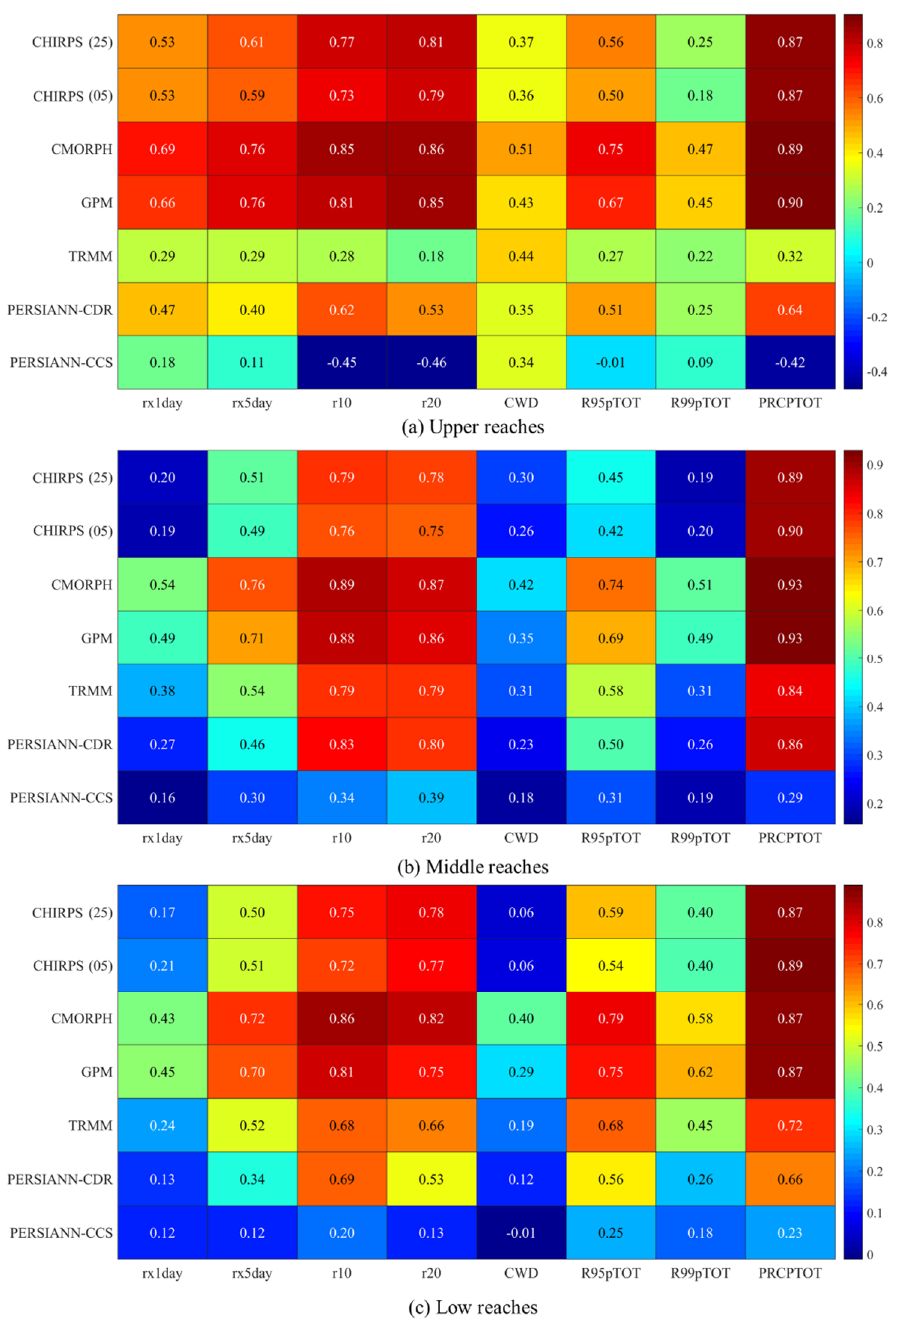
Figure 5. R values between eight extreme precipitation indexes obtained from SPPs and gauge observations.